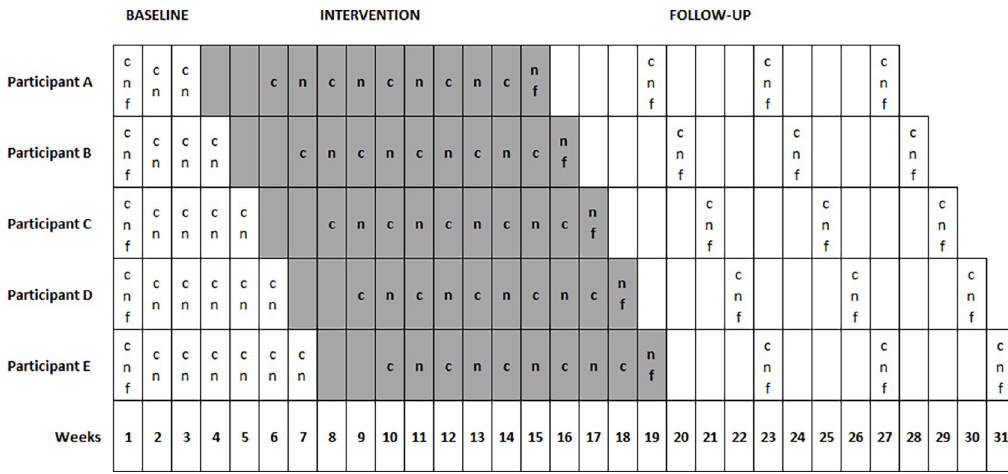
Fig 1. Timeline and schematic representation of the study’s design. Grey colour represents the intervention phase. Each row (A-E) represents a different participant. (c) clinical assessment. (f) Modified Fatigue Impact Scale questionnaire. (n) neurophysiological assessment via TMS. Every cell represents a different week, so every procedure which is included (i.e., c, n, f) will be performed during the corresponding week but in different days.